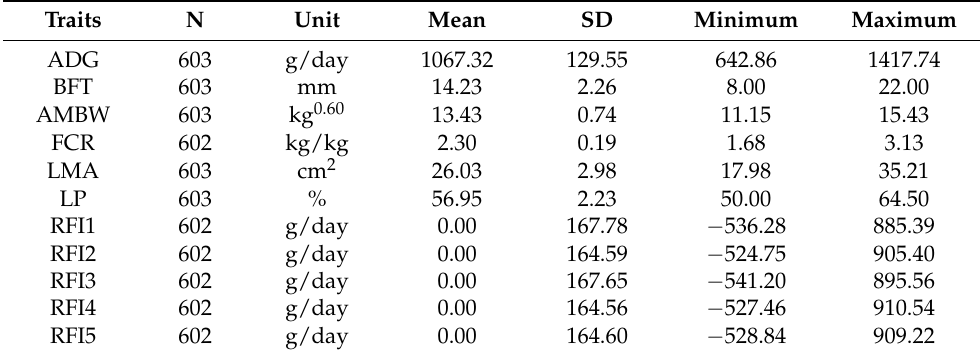
Table 1. Descriptive statistics of production and feed efficiency trait of Duroc